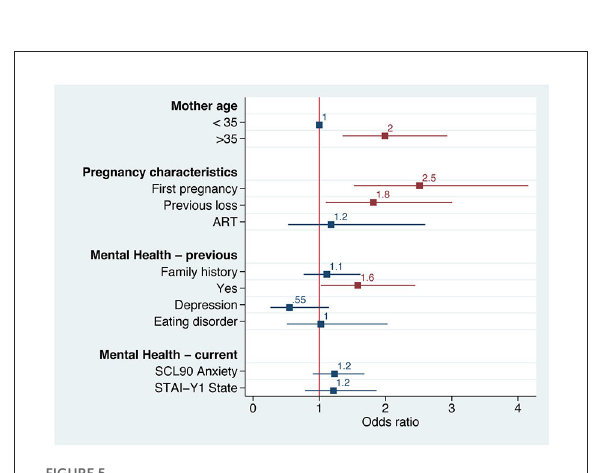
FIGURE5 Forest plot of the logistic regression of probability of not exclusively breastfeeding according to the most theoretically and statistically significant variables. Numbers and squares represent odds ratios, horizontal line represents 95% CI, red color p <